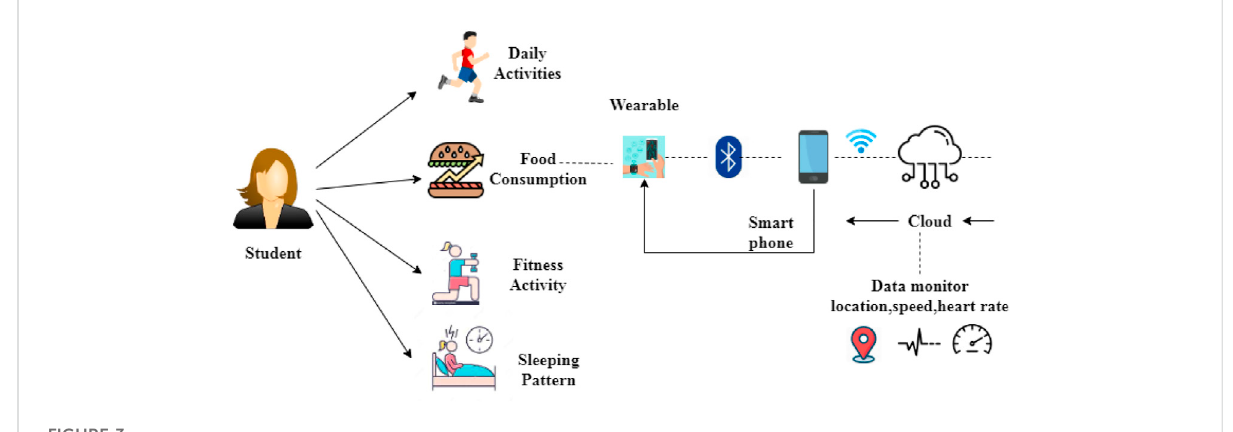
FIGURE 3 Fitness tracking